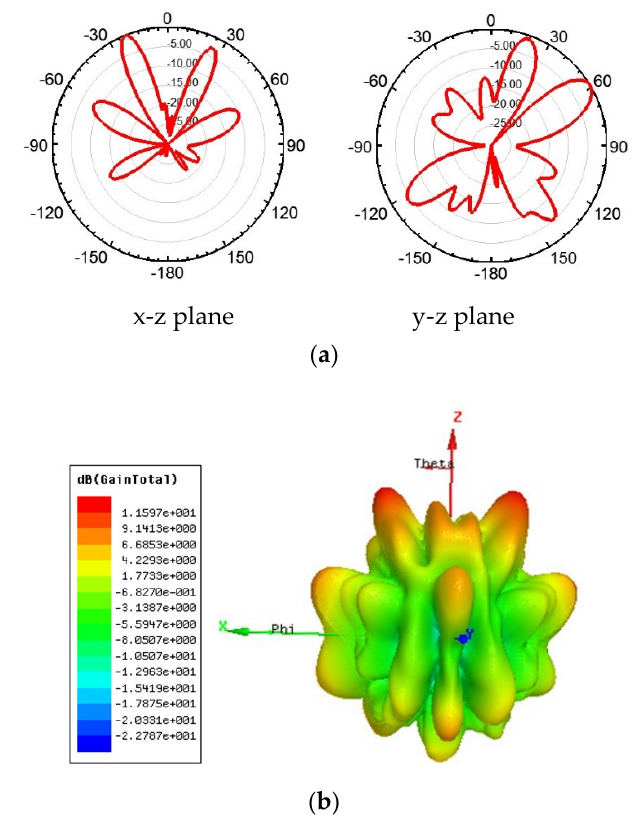
Figure 16. Simulated radiation characteristics of a single antenna ( a ) 2-D radiation pattern; ( b ) 3-D radiation pattern.